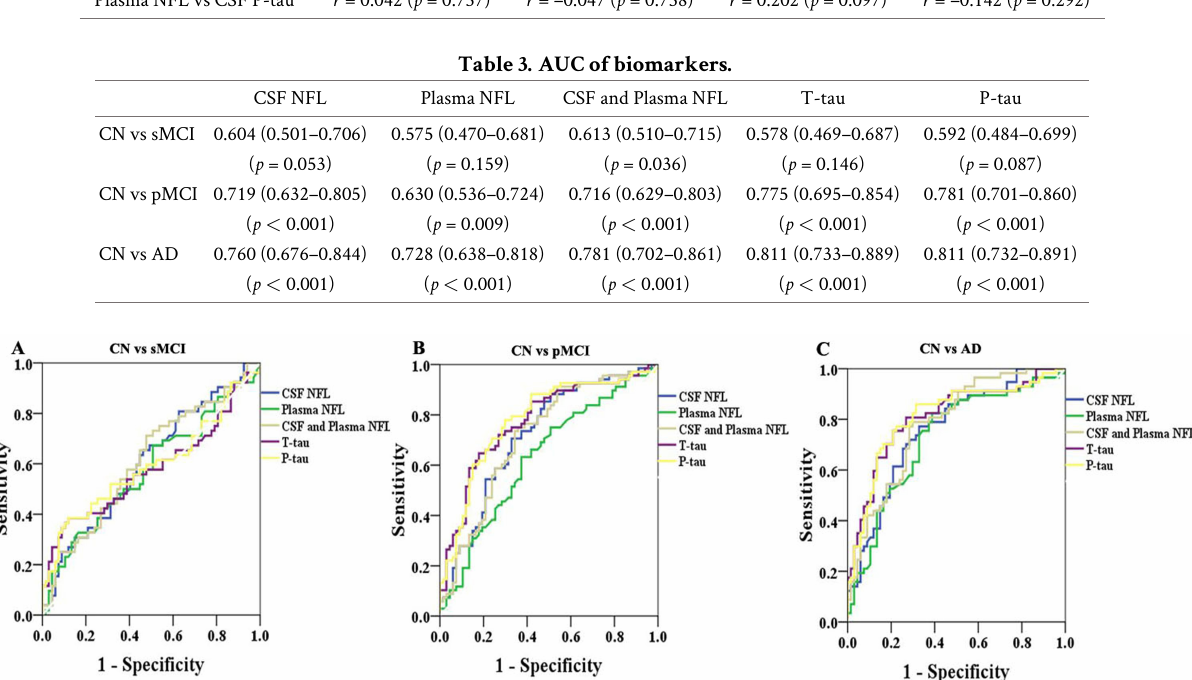
Fig. 4. ROC analyses. ROC analyses were used to assess the CSF biomarkers associated with clinical diagnoses for sMCI (A), pMCI (B), and AD (C).